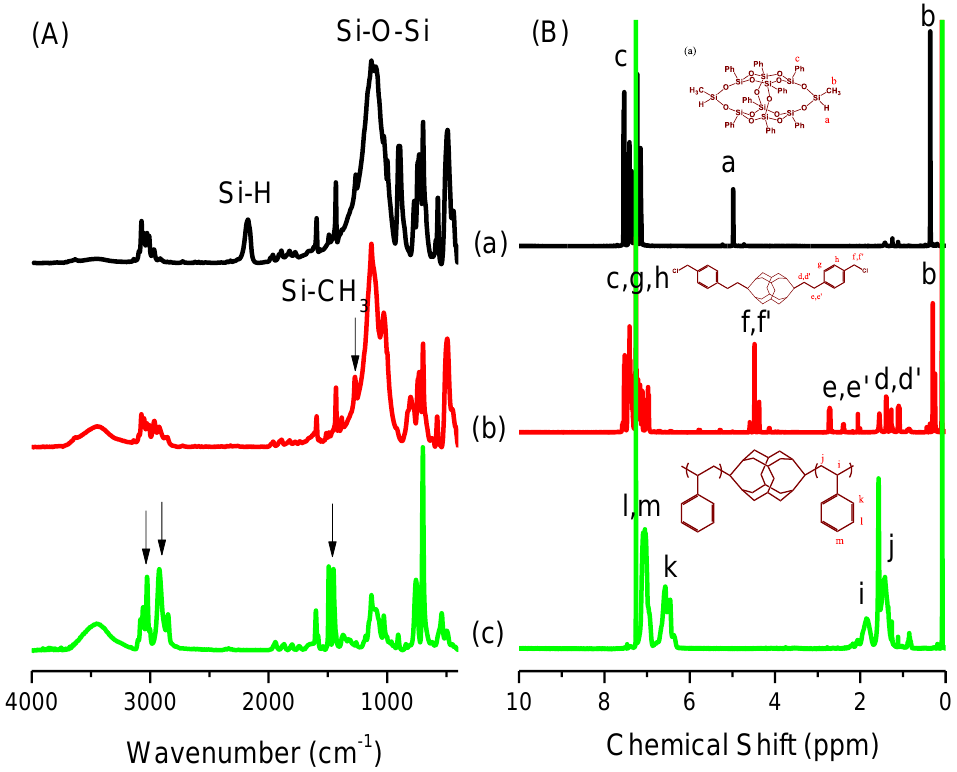
Figure 1. ( A ) FTIR and ( B ) 1 H NMR spectra of ( a ) DDSQ, ( b ) VBC-DDSQ-VBC, and ( c ) PS-DDSQ-PS.